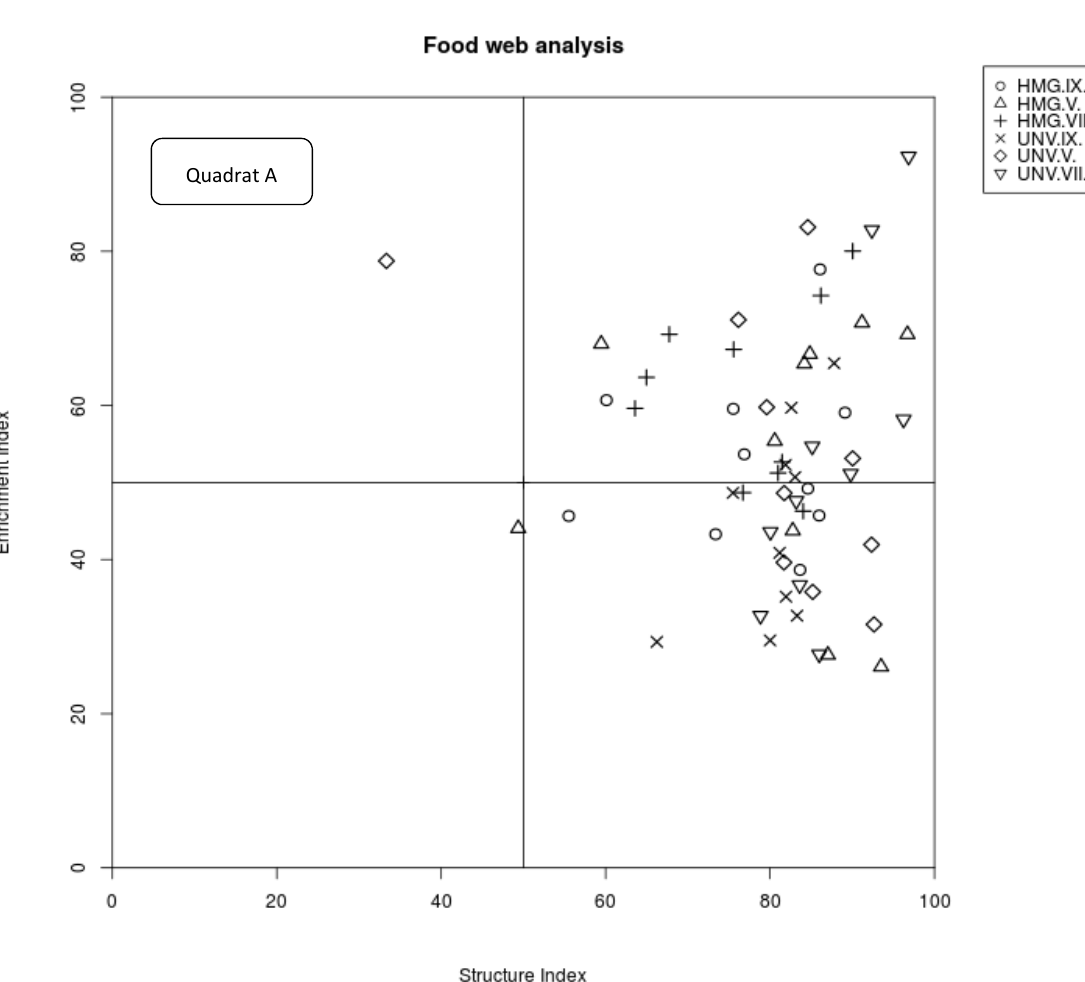
Figure 2. Faunal profiles of Heracleum mantegazzianum invaded (HMG) and uninvaded control (UNV) plots, representing the food web condition in relation to its structure (SI) and enrichment (EI), as indicated by the “weighted faunal analysis” following Ferris et al. (2001). Quadrat A should comprise nematode communities in an environment with a high degree of disturbance of the food web, N-enriched with low C/N ratio, and prevailing bacterial decomposition channel. Quadrat B represents an environment with a low to moderate degree of disturbance and maturing food web, N-enriched, and with balanced decomposition channel as well as low C/N ratio. Quadrat C represents an environment with an undisturbed and structured food web and relatively low primary production, fungal decomposition channel, and moderate to high C/N ratio (climax like). Quadrat D represents an environment with stressed and degraded food web condition, depleted with fungal decomposition channel, and high C/N ratio. Symbols represent soil samples collected in May (V), July (VII), and September (IX) of two vegetation